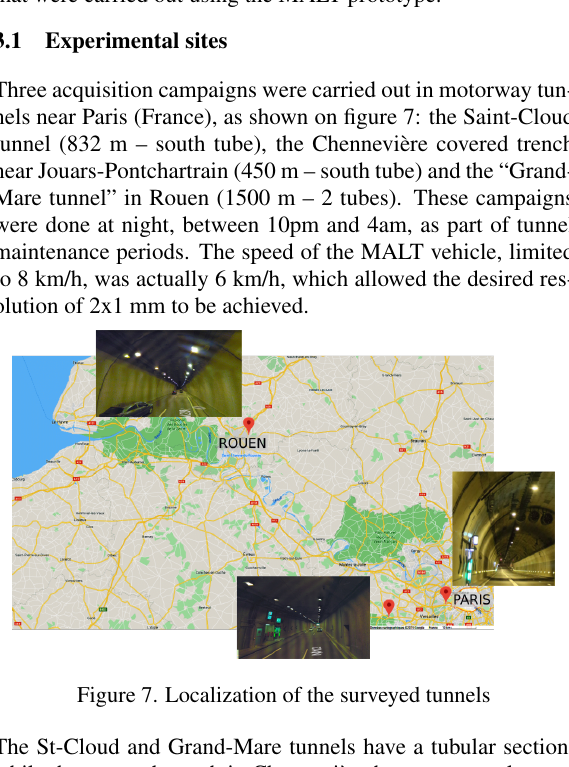
Figure 5. Positioning of the front LIDAR (top) and interface for checking the distance between the vehicle and the tunnel walls (bottom).